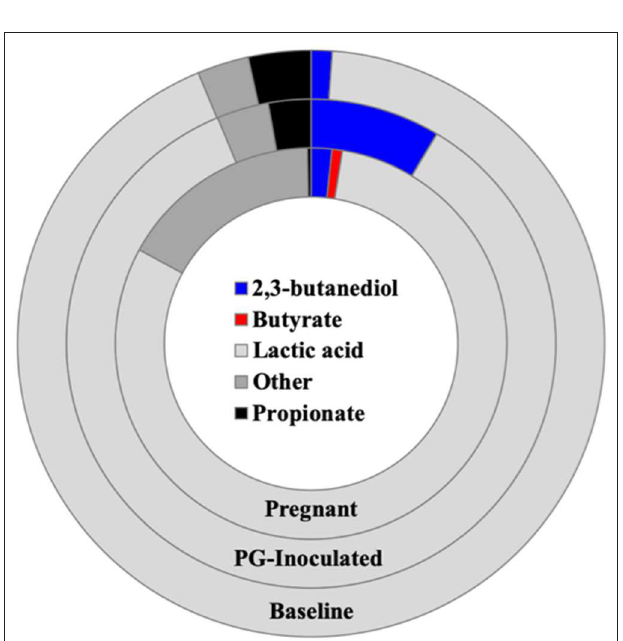
FIGURE 11 | Population proportion of identified community members in terms of predicted metabolic characteristics as a major generator of target microbial metabolites for baseline, PG-inoculated, and pregnant groups.